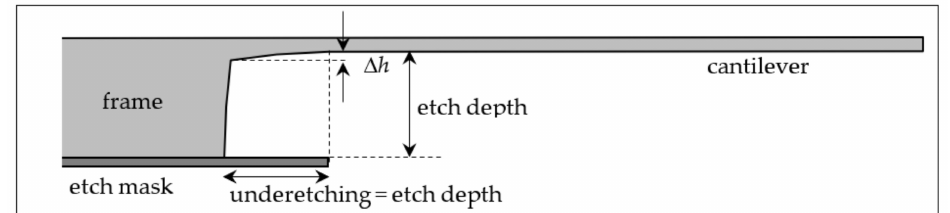
Figure 13. Illustration of the increasing thickness ∆ h of a cantilever toward the frame under the etch mask. ∆ h amounts of about 3.5, 4.5, 5 and 5.3 µ m for thicknesses of 200, 100, 70 and 45 µ m (and respective etch depths of 325, 425, 455 and 480 µ m). The length of the underetching is approximately equal to the etch depth from the beginning of the